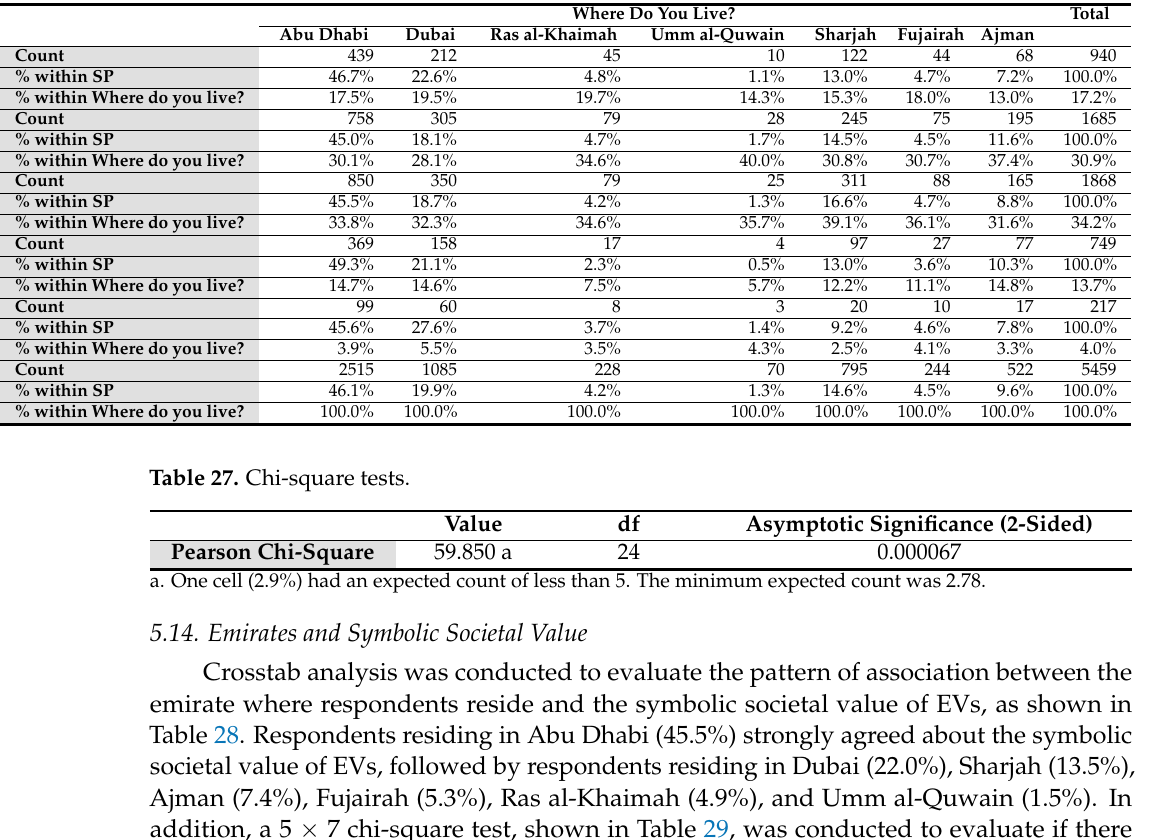
Table 26. Symbolic private value of EVs and respondents’ emirates cross-tabulation.